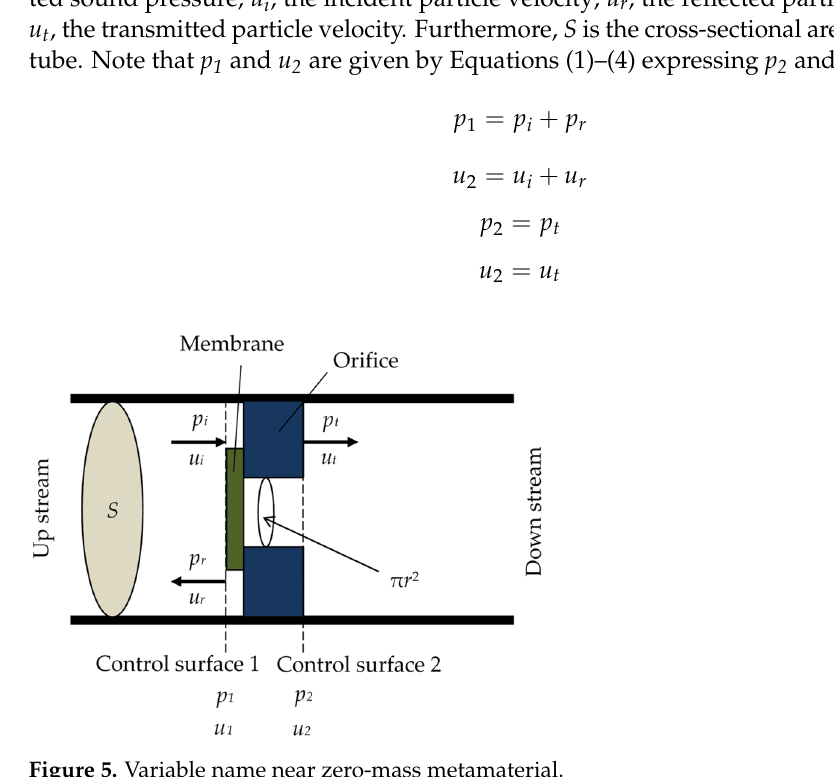
Figure 4. Analytical model for zero-mass metamaterials.